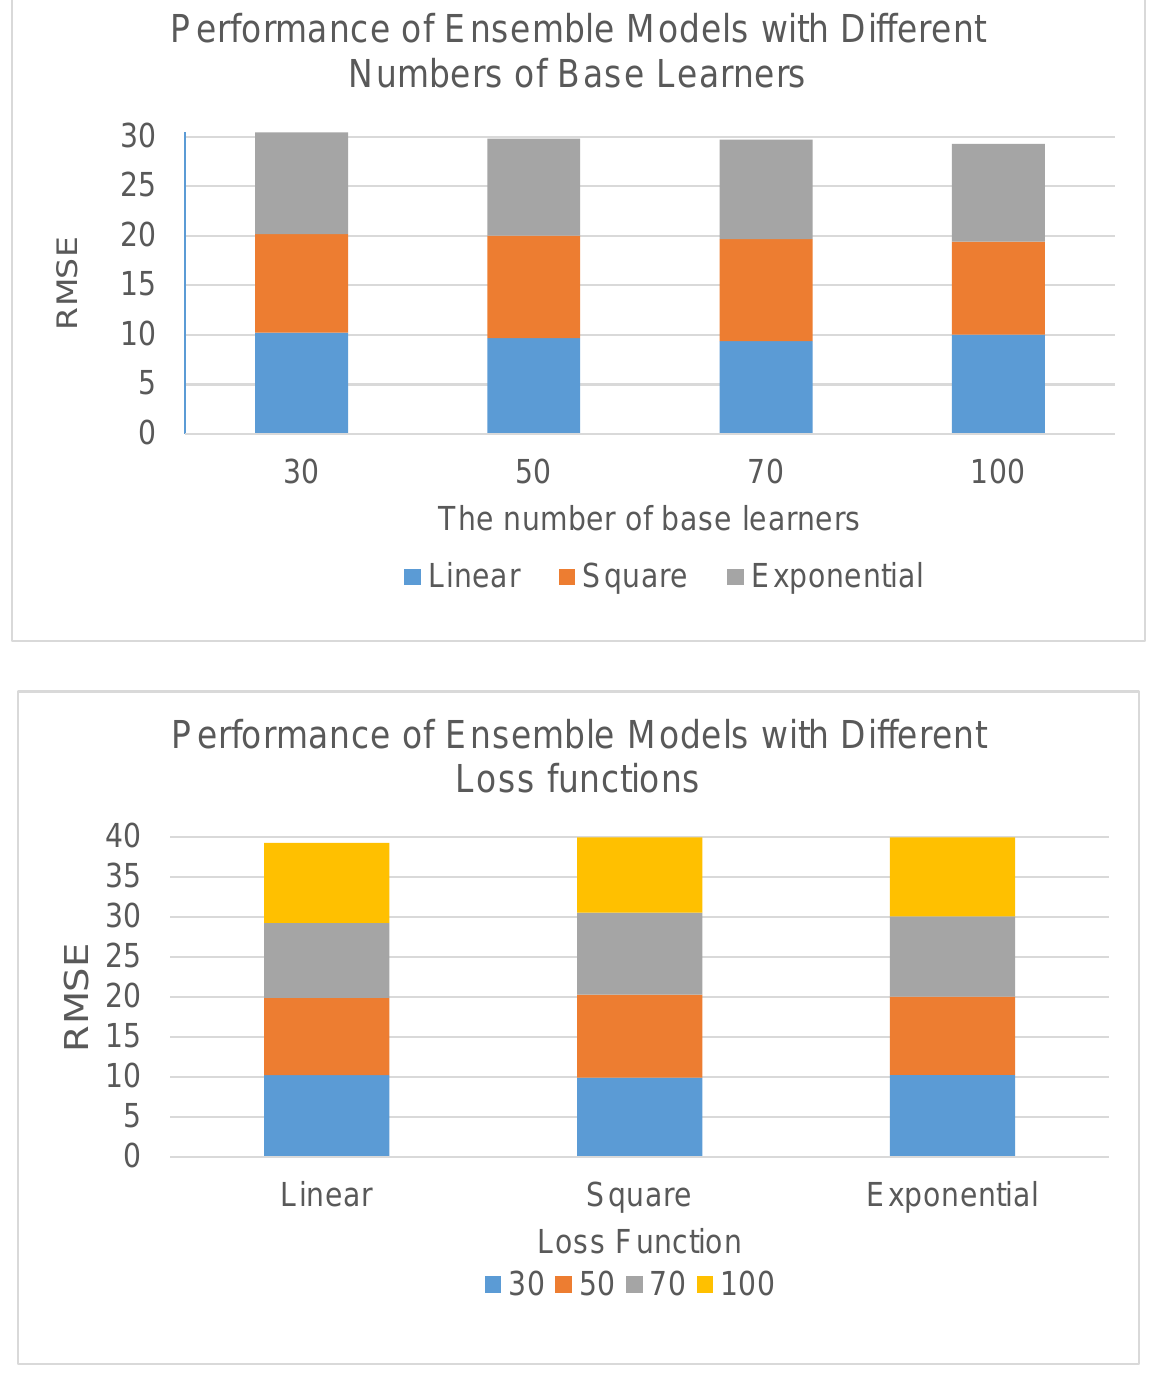
Figure 7. The overall result chart of ensemble learning module with different parameters.